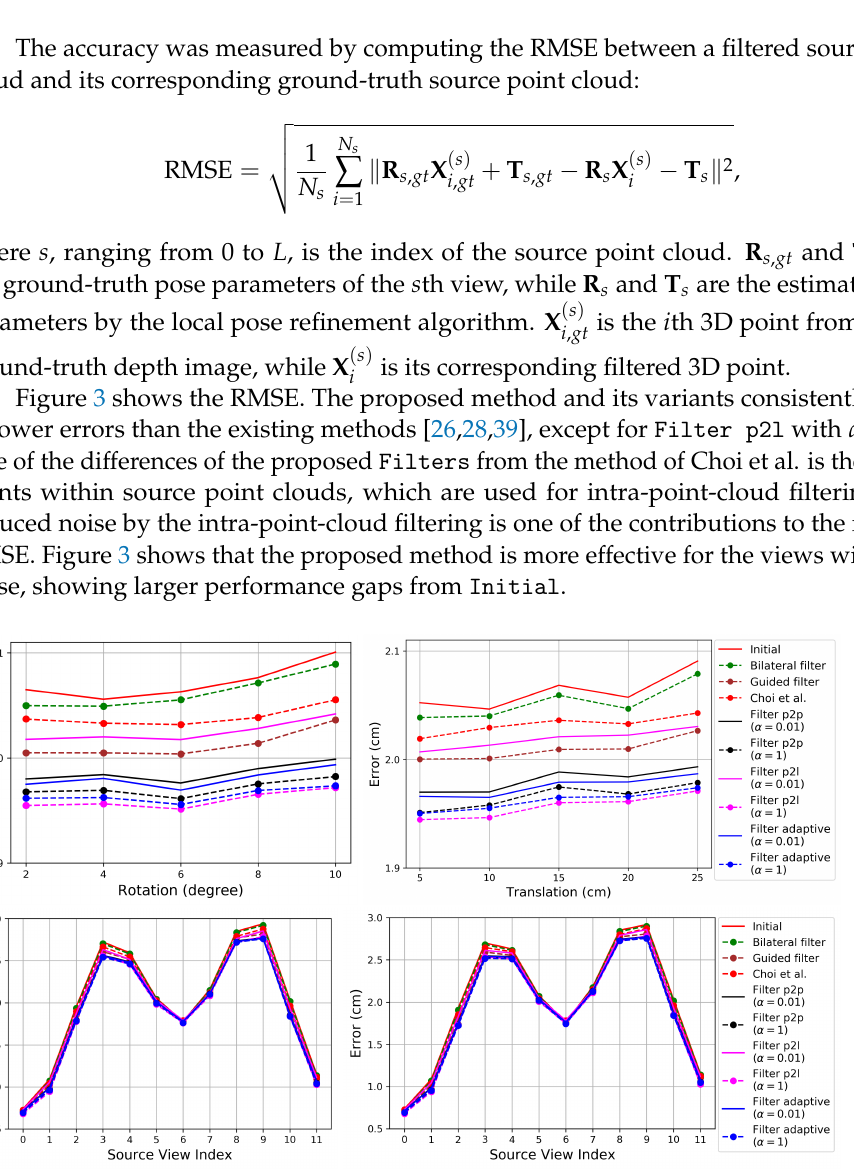
Figure 3. Evaluation of the depth refinement algorithms on the synthetic dataset of Choi et al. [26]. The algorithms are initialized with the estimated transformations by a local pose refinement algo- rithm [26] applied to the transformations that are perturbed away from the true pose. ( Top ): Error according to different perturbation levels in the rotational ( left ) and translational ( right ) components. ( Bottom ): Error according to the source view index with perturbation levels 10 ◦ ( left ) and 25 cm ( right ). The plot shows the median RMSE. Lower is better. Best viewed in